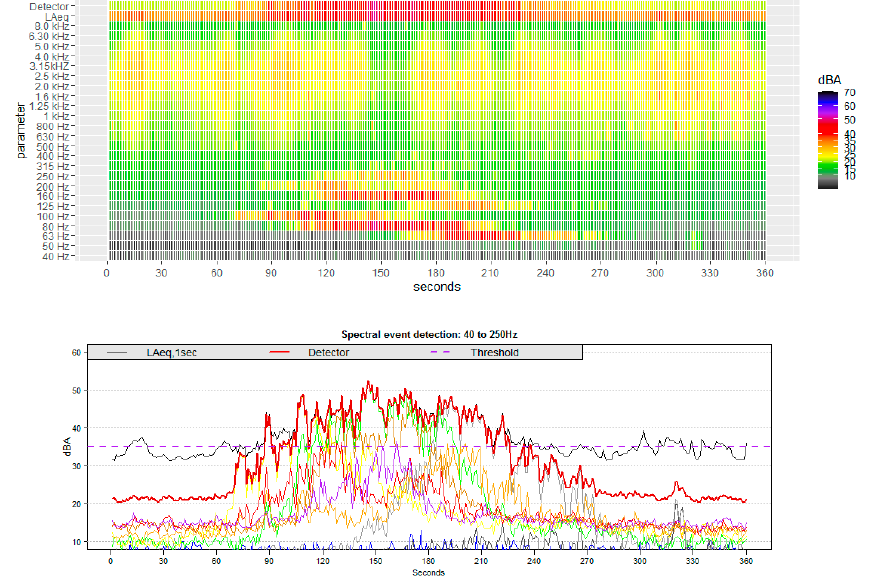
Figure 5. Tonal spectrogram in third-octave bands of a propeller aircraft event with a duration of 3.5 min (Antonov AN-12BK Ukraine Air Alliance). The shift in spectral content from high to low is the result of the Doppler effect increasing the frequency at the receiver for an approaching source and decreasing for a receding source. The L Amax is 50 dBA for a pass-by at a 15-km horizontal distance and an altitude of 6500 m with horizontal speed of 250 km/h and a vertical speed of 0